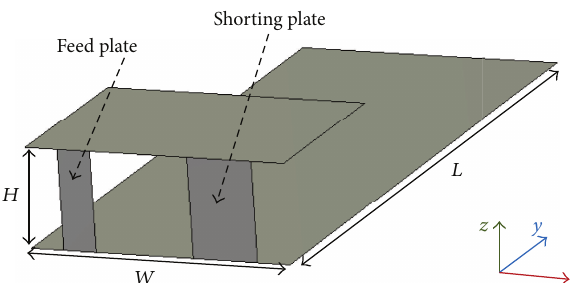
Figure 2: A PIFA where bandwidth enlargement can be achieved by optimizing the widths of the feeding and shorting plates [12].